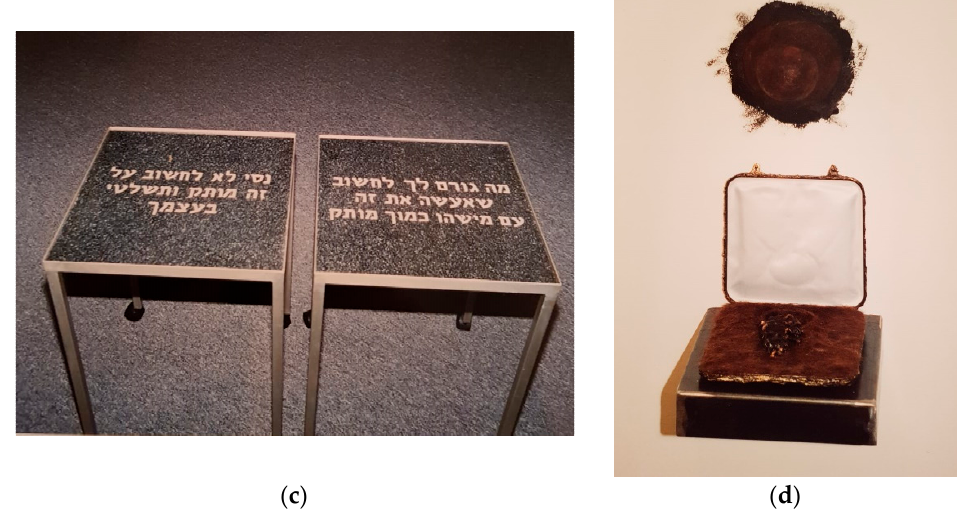
Figure 8. ( a ) Anat Massad, For the Sake of the Plot , detail, 1996. Mixed media: iron, hair, text. The artist’s collection, Kfar Masaryk. Detail (left); ( b ) Detail (middle); ( c ) Detail (left); ( d ) Detail (right). Courtesy of Anat Massad.